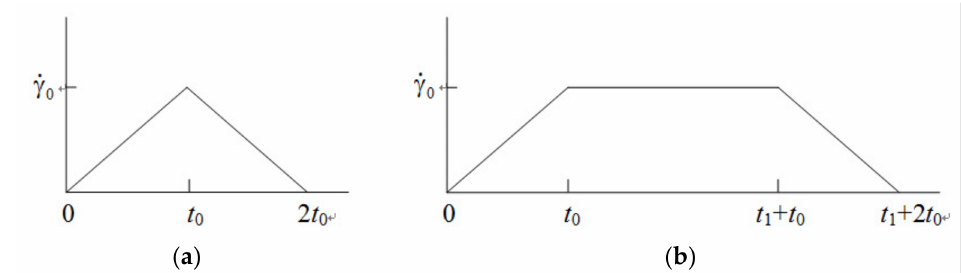
Figure 1. Schematic diagrams of loop experiments, ( a ) triangular-loop, and ( b )